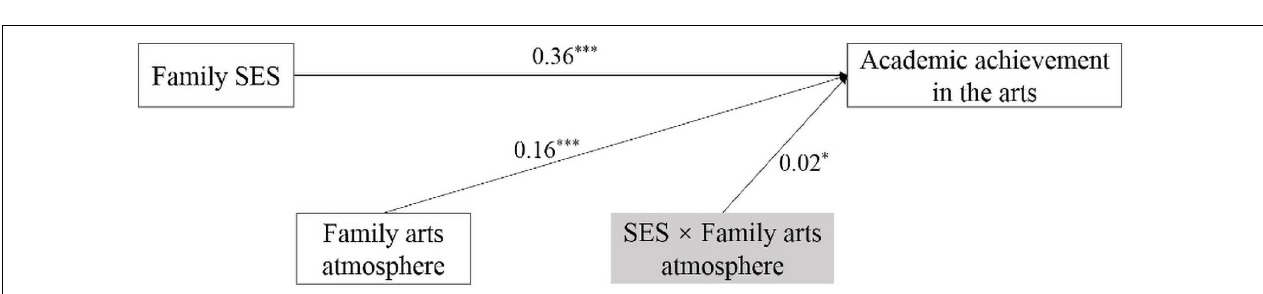
FIGURE 3 | Moderated model of family arts atmosphere. Notes: Control variables were gender and school location. All continuous variables were standardized before they were entered in the path analysis model. Estimates are standardized coefficients, * p < 0.05, ** p < 0.01, and *** p <